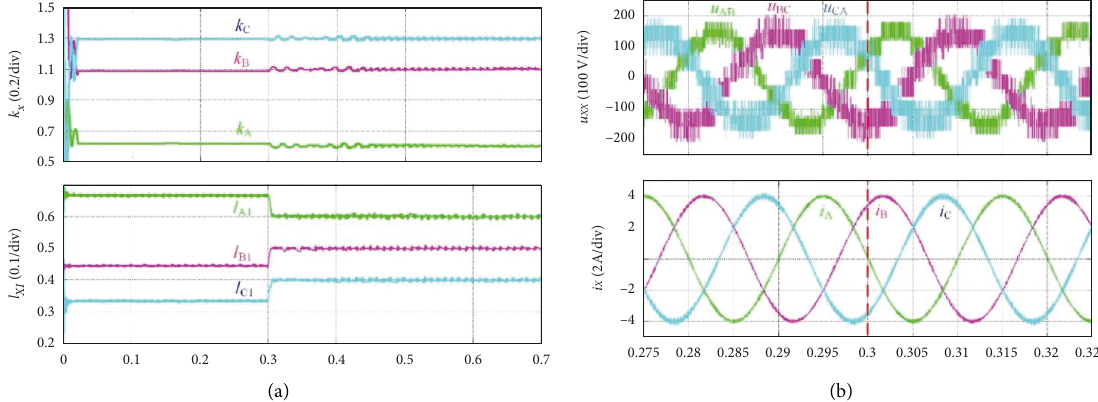
Figure 4: The simulation results with r A (cid:31) 2/3, r B (cid:31) 1, and r C (cid:31) 4/3: (a) waveforms of power generation ratios k X and submodule power generation ratios l X 1 and (b) waveforms of line voltage u XX and currents i X .